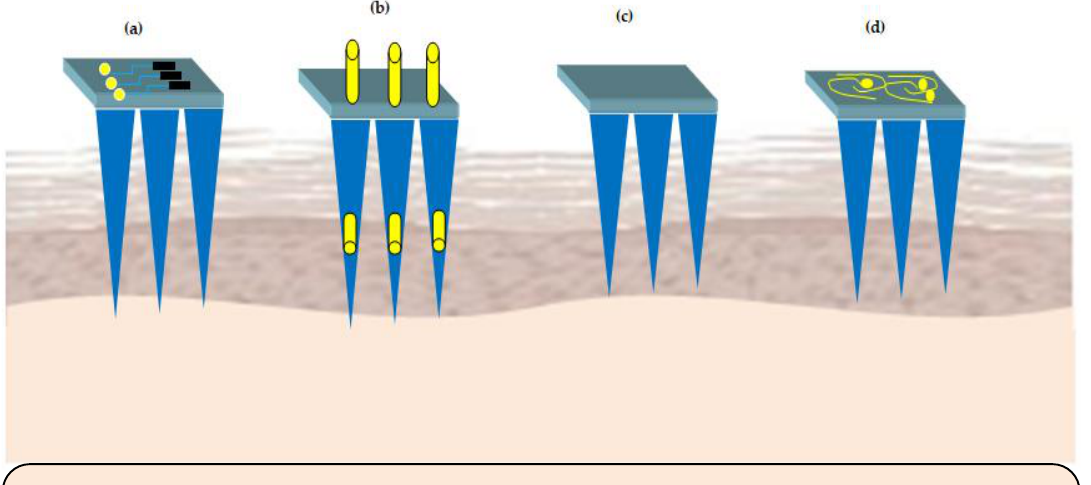
Figure 5. Microneedles (MNs) sensing modalities ( a ) sensor positioned on the MNs base or support ( b ) electrode inserted into the hollow microneedles—acts electrochemically ( c ) surface of the MNs is functionalized to act as a sensor ( d ) MNs are metallized to act as bio-electrodes. The sensors for MNs basically comprise of analyte recognition element and a transducer (electrochemical or optical). As regards the colorimetric MNs sensor, the enzyme glucose oxidase is